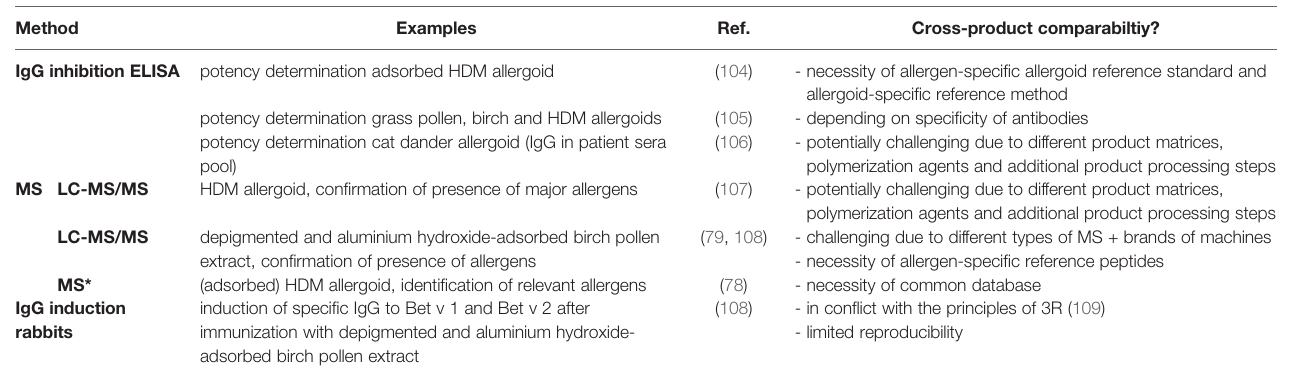
TABLE 4 | Analytical methods for standardization of chemically modi fi ed and/or absorbed allergen